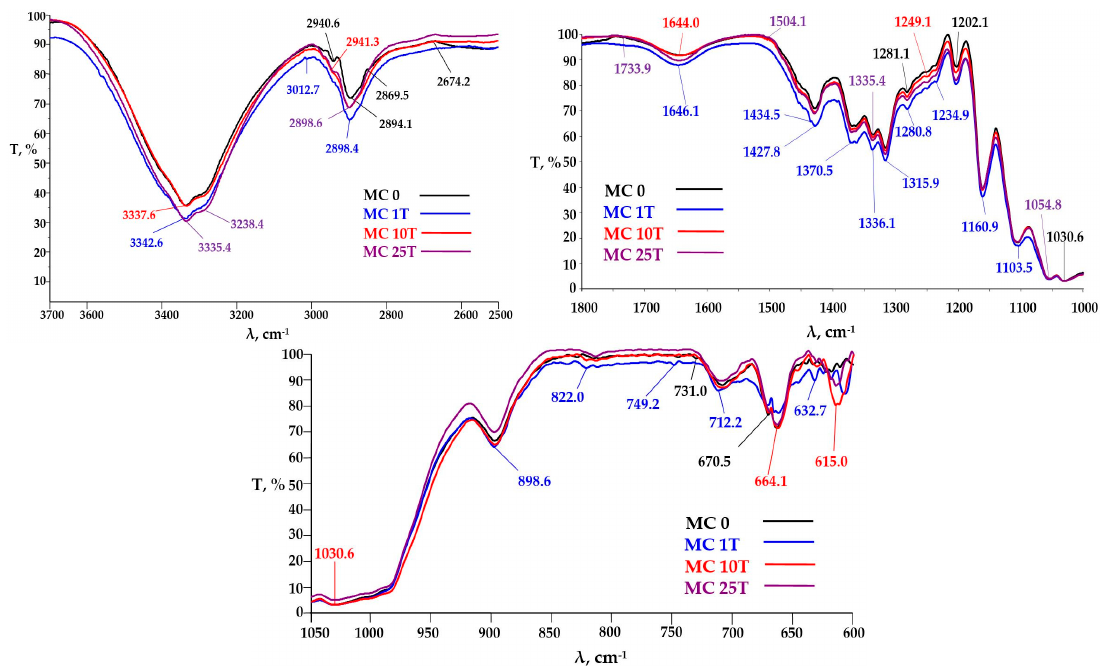
Figure 9. FTIR spectra of micro-crystalline cellulose (MC) samples after different number of passes through microfluidizer.